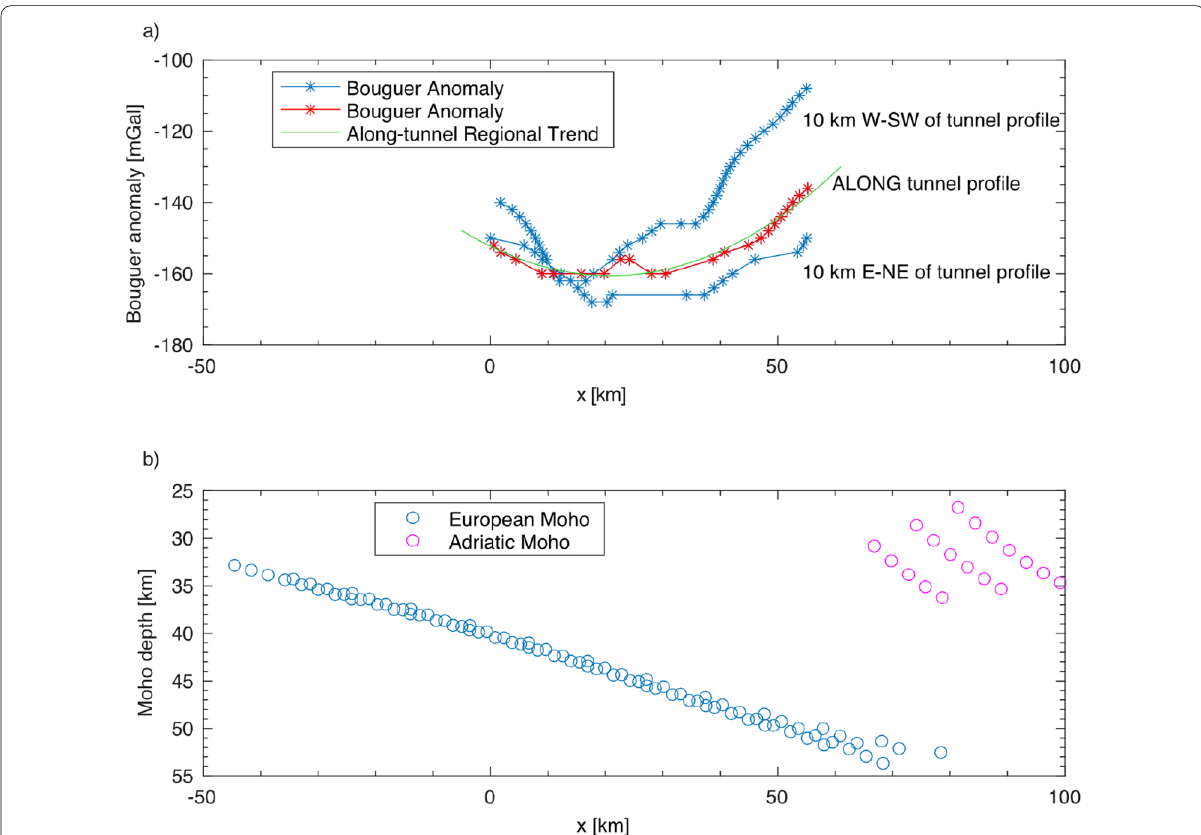
Fig. 5 a Bouguer gravity anomaly field sampled along the tunnel profile (red), and along two parallel profiles to the W-SW and to the E-NE of the tunnel profile, here reported for comparison (blue). The green line represents the regional Bouguer anomaly trend, interpolated with a 2 nd order polynomial and removed from the data to account for the large-scale crustal thickness variations, as shown in panel b . The Bouguer anomaly data shown here is provided by swisstopo, accessible at map.geo.admin.ch with layer name “Bouguer anomalies 500” (i.e. Bouguer gravity anomaly map of Switzerland 1:500,000). b European and Adriatic Moho depths sampled along the tunnel profile, and along two parallel profiles to the W-SW and to the E-NE of the tunnel profile, as in panel a . Moho depth information from Spada et al.